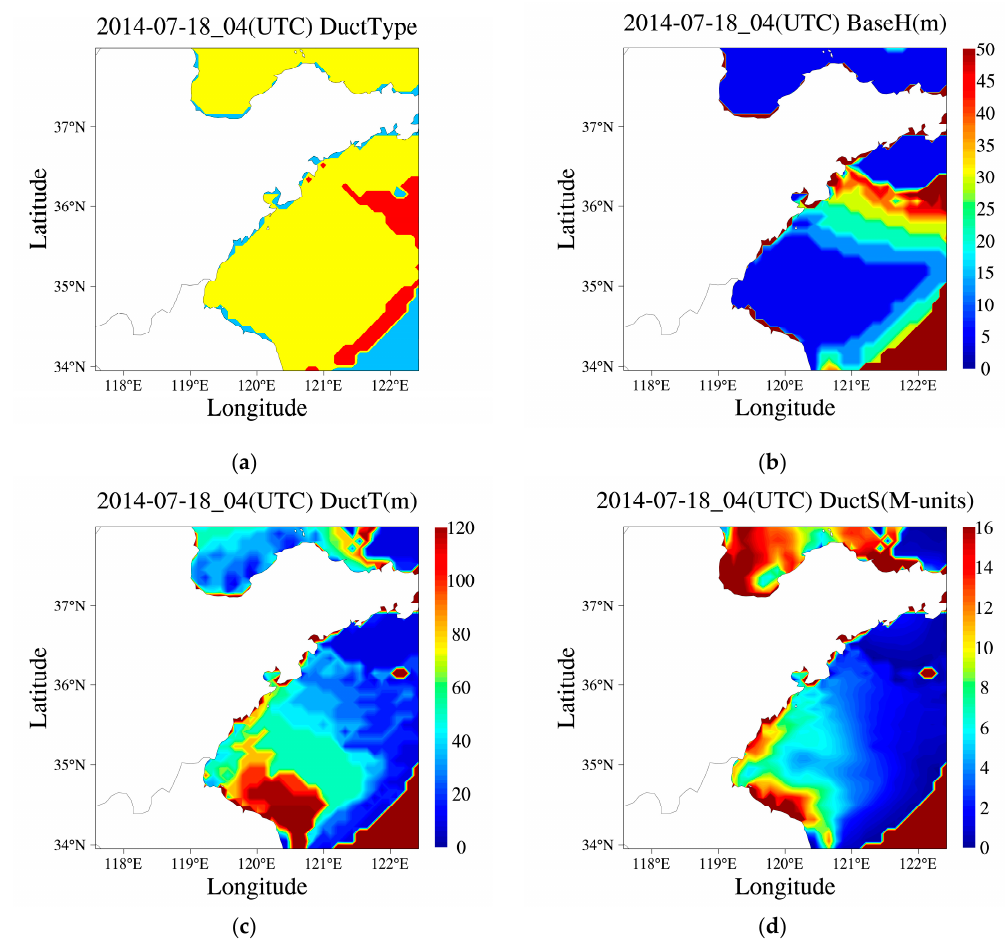
Figure 10. Regional distributions of tropospheric ducts and duct parameters: ( a ) tropospheric ducts (the yellow regions represent surface ducts and the red regions represent elevated ducts); ( b ) base-layer height (m); ( c ) duct-layer thickness (m); and ( d ) duct-layer strength (M-units).